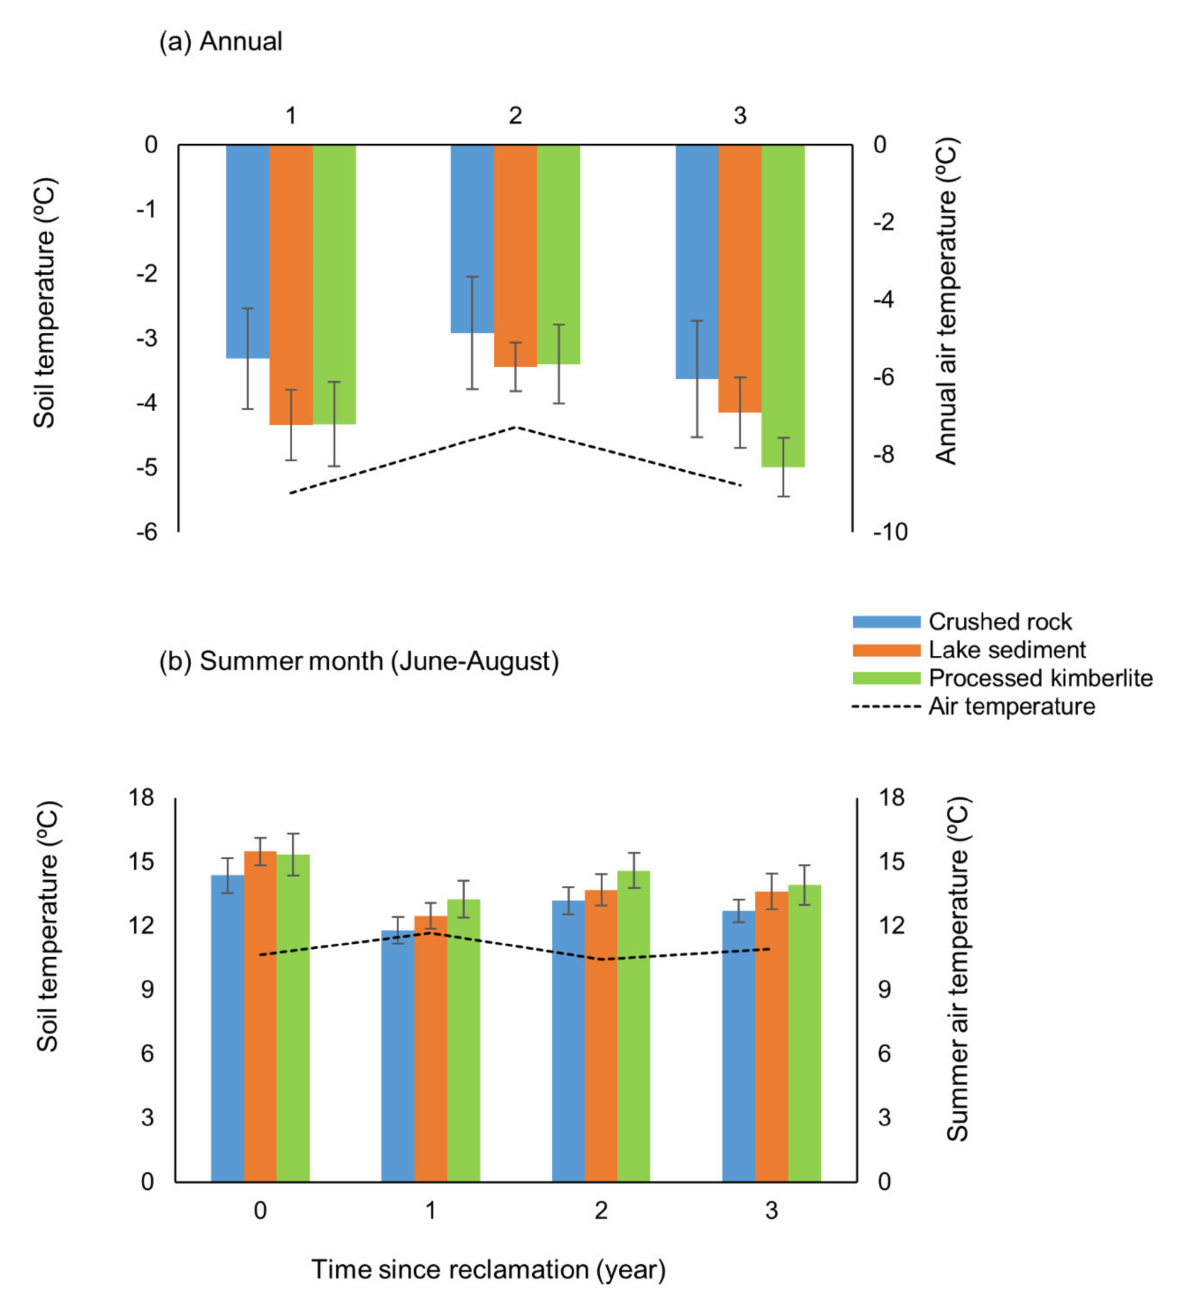
Figure 5. Mean ( a ) annual and ( b ) summer month soil temperature by substrate type and air temperature at the research